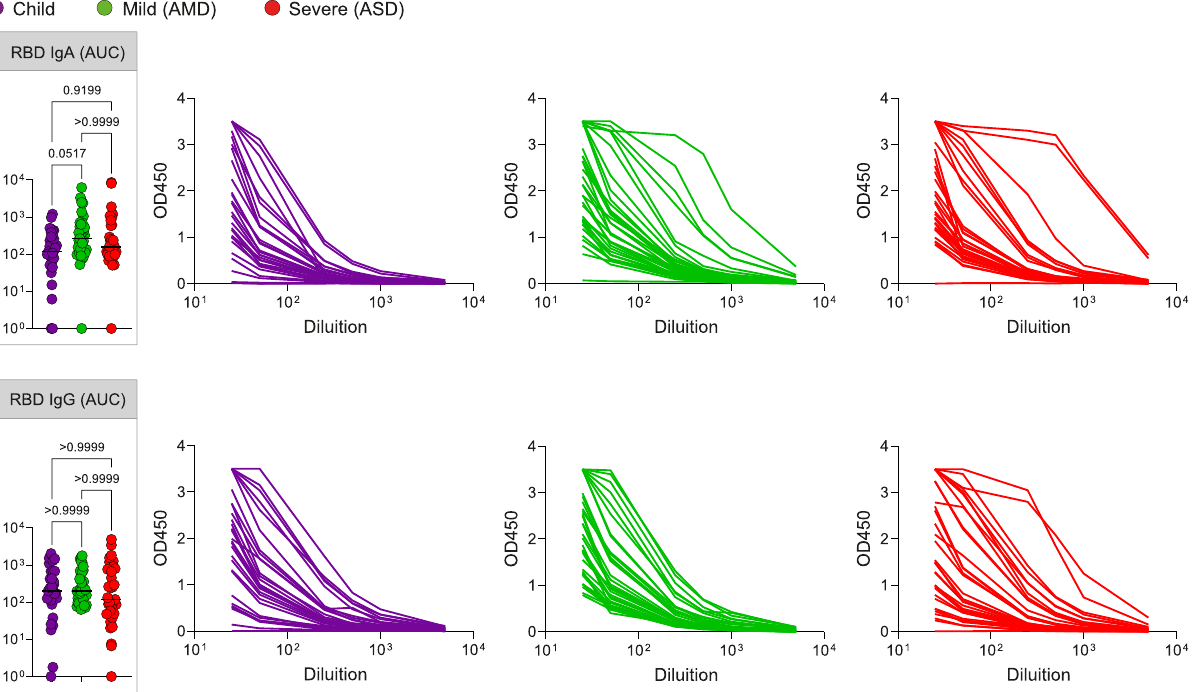
Fig. 4 Antibody responses. SARS-CoV-2 spike RBD IgA and IgG antibody titers determined by ELISA using serial dilutions of plasma. Individual titration curves for individuals (represented by a line, color coded) and analysis of variance (Kruskal-Wallis) of the values calculated as the area under the curve (AUC) for IgA ( A ) and IgG ( B ) are displayed. P values are displayed over brackets, the horizontal bar representing the median. Source data are provided as a Source Data fi